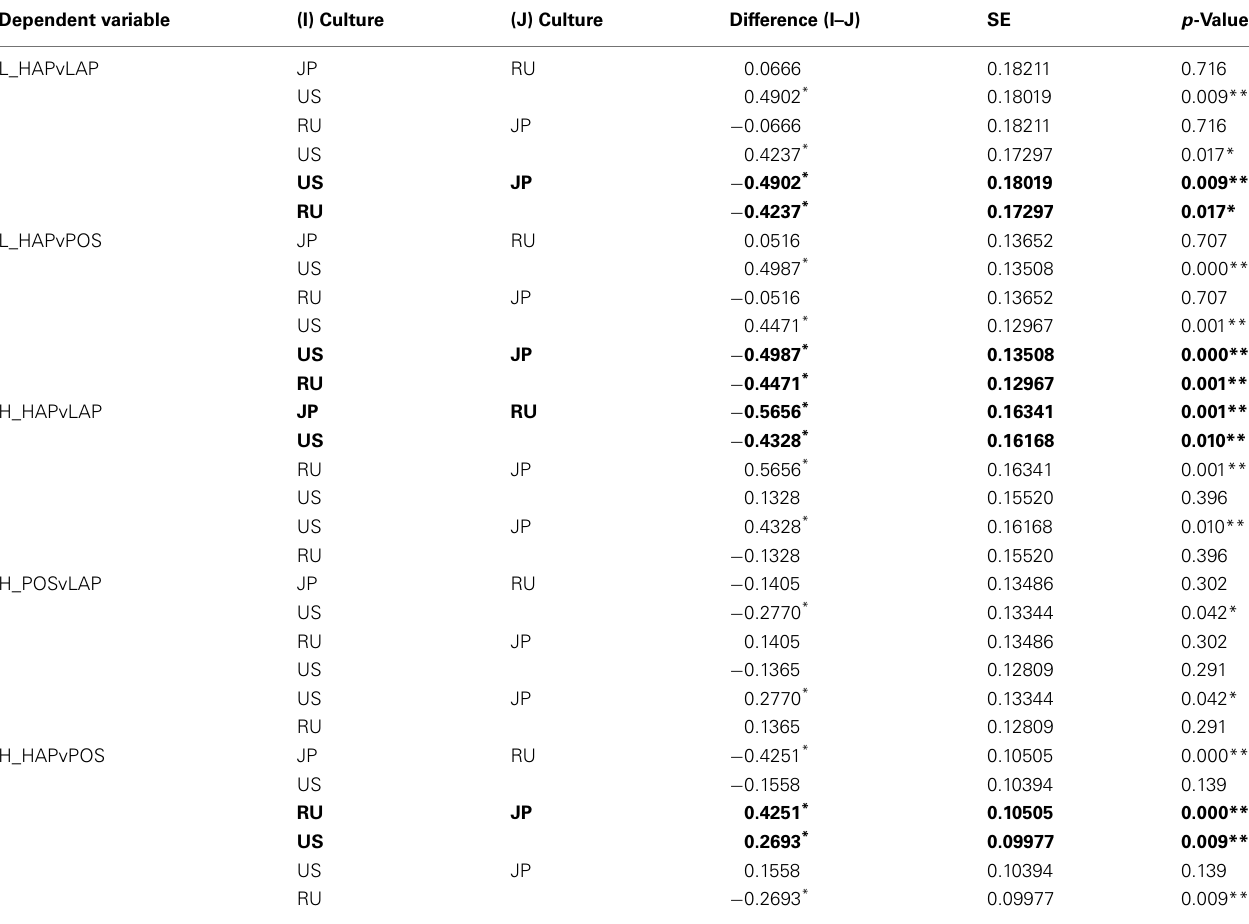
TableA13 | Post hoc comparisons of categorization difference scores from ipsatized